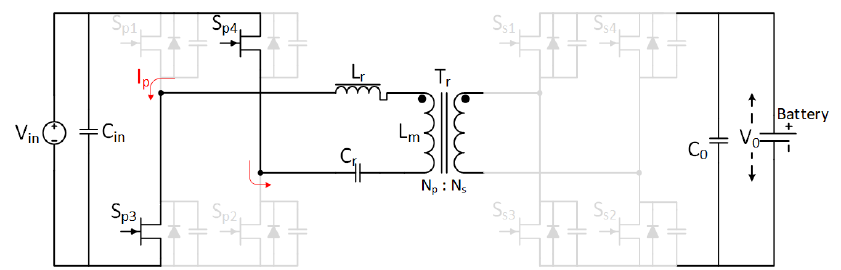
Figure A6. LLC resonant converter topology